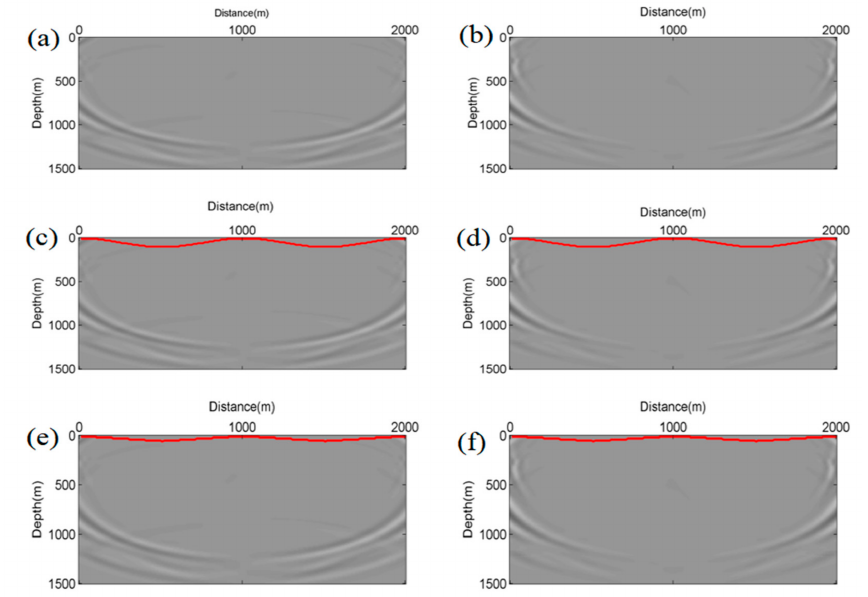
Figure 8. Forward S-wave wavefield at 600 ms for graben elastic models with different topographies. The left panels are the horizontal S-wave particle velocity, and the right panels are the vertical S-wave particle velocity. Panels ( a , b ) are the forward S-wave wavefield for graben elastic model with a horizontal topography, panels ( c , d ) are the forward S-wave wavefield for graben elastic model with a sinusoidal topography, and panels ( e , f ) are the forward S-wave wavefield for graben elastic model with a triangular topography. The red line is the surface topography.